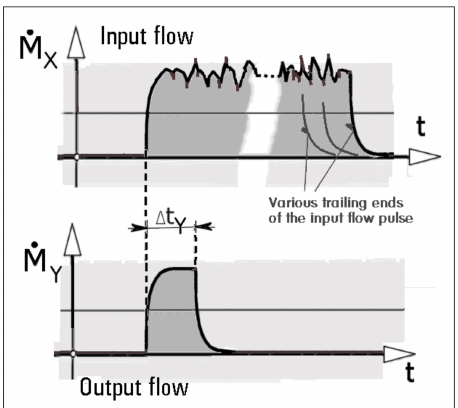
Figure 3. Typical flow of a fluidic pulse shaper as seen in oscilloscope traces of mass flow rate. In response to the distorted input pulse (of various lengths, top) a standard duration ∆ t Y output pulse (bottom) is generated in the output terminal.